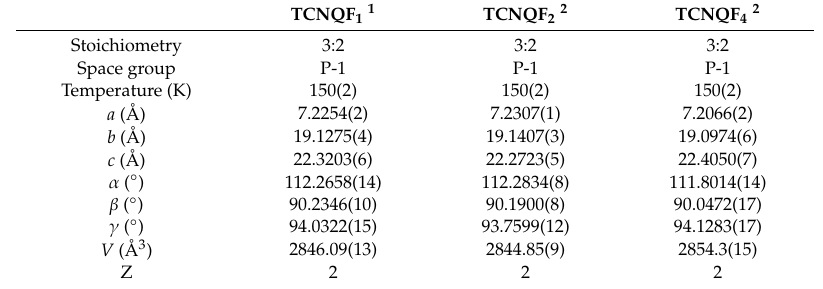
Figure 2. Crystal structure of (Perylene) 3 -(TCNQF 1 ) 2 . Table 1. Basic structural parameters of the three isostructural CT crystals Perylene–TCNQF x 3:2.